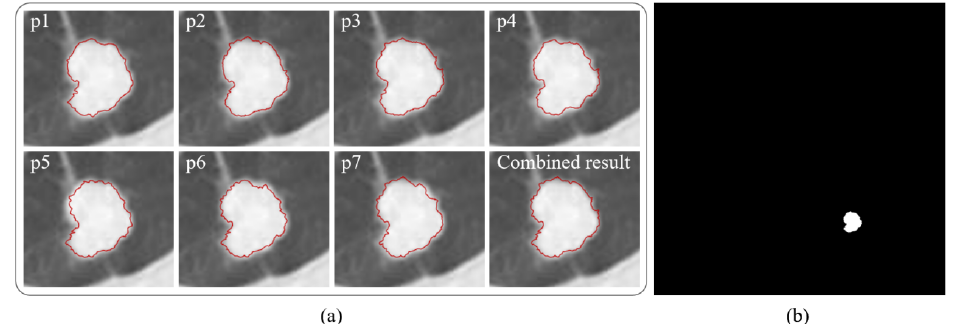
Figure 4. The segmentation result of our proposed method, and the red circle is the tumor boundary obtained after segmentation, ( a ) the target tissue contour obtained from the initial seed points of p1, p2, p3, p4, p5, p6, and p7, respectively, and their combination results, ( b ) final segmentation result.